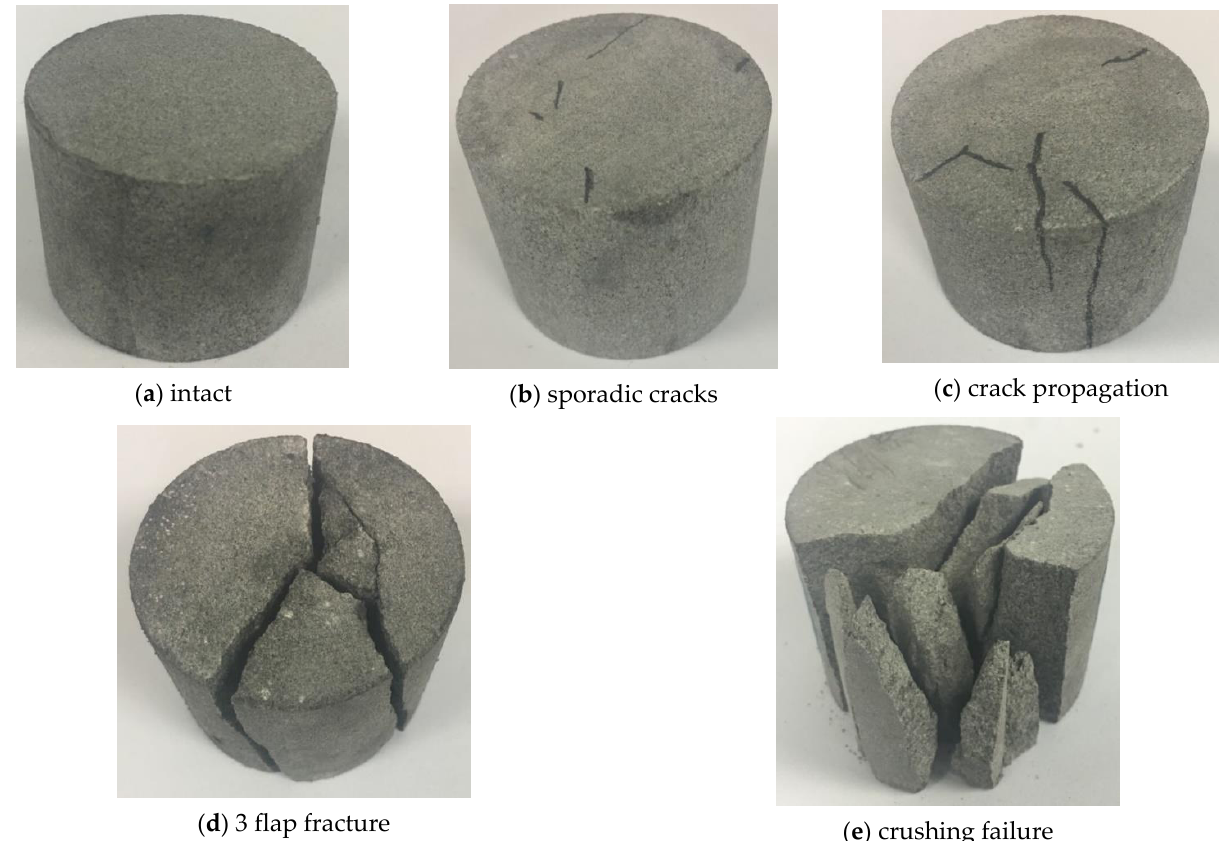
Figure 7. The failure pattern of sandstone under a single